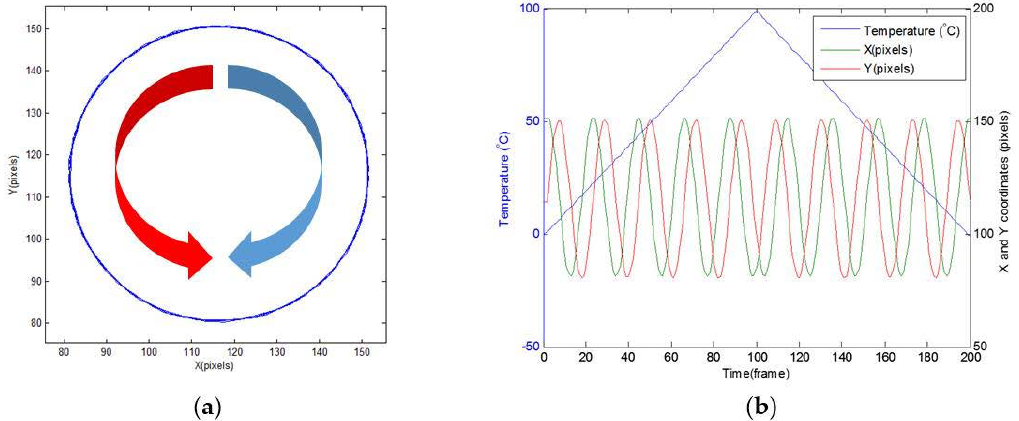
Figure 4. Center of mass calculation: rotating pattern in the counterclockwise direction for heating and in the clockwise direction for cooling ( a ), and coordinates along the X and Y axes of the center of mass ( b